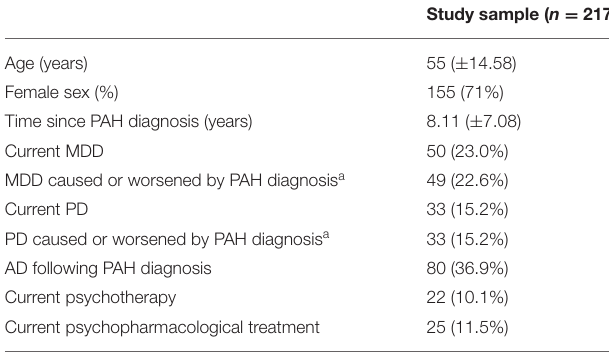
TABLE 1 | Participant